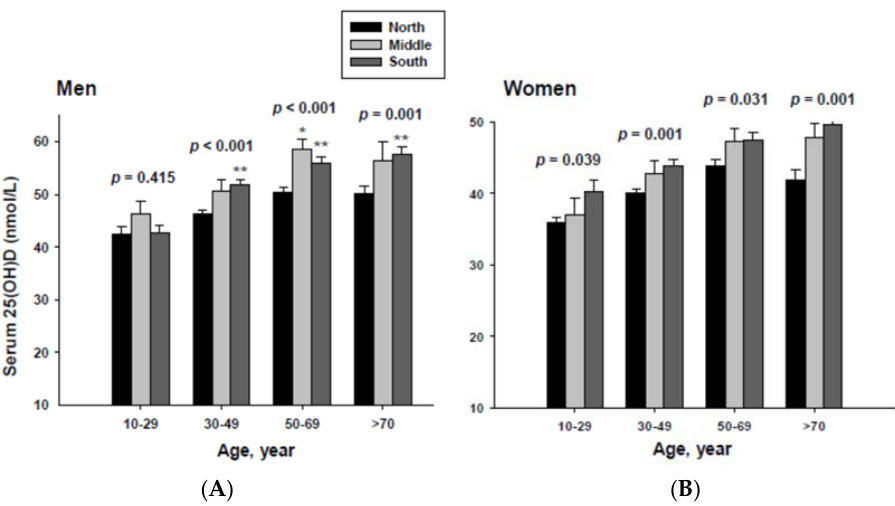
Figure 2. Adjusted mean serum 25(OH)D concentrations according to age and geographic location in men ( A ) and women ( B ). The p values are p for trend in the same group from ANCOVA test adjusted for total body fat, smoking, job, alcohol intake, moderate activity and education for men, and for total body fat, smoking, job, alcohol intake, moderate activity, education, menopause, oral contraceptive use and hormone replacement therapy for women Subject numbers for men are 10–29 years old, 832, 151, 591; 30–49 years old, 1296, 267, 985; 50–69 years old, 976, 286, 902; ≥ 70 years old, 325, 120, 333 for North, Middle and South, respectively, and for women are 10–29 years old, 806, 192, 556; 30–49 years old, 1358, 255, 1017; 50–69 years old, 714, 248, 785; ≥ 70 years old, 304, 131, 413 for North, Middle and South, respectively. * p < 0.05, North vs. Middle; ** p < 0.05 North vs. South.